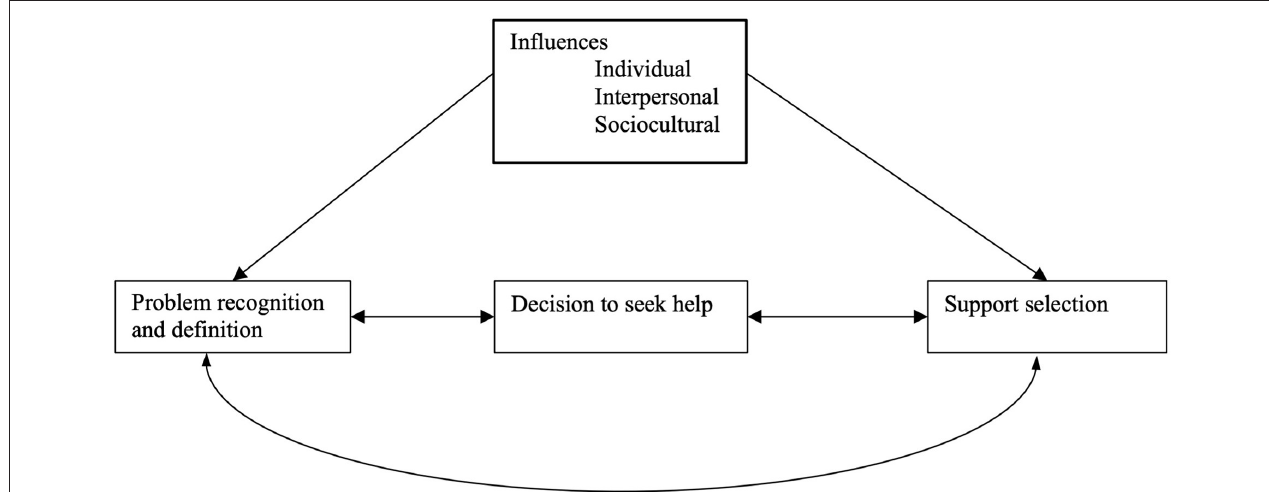
FIGURE 1 | Liang’s help-seeking framework for intimate partner violence